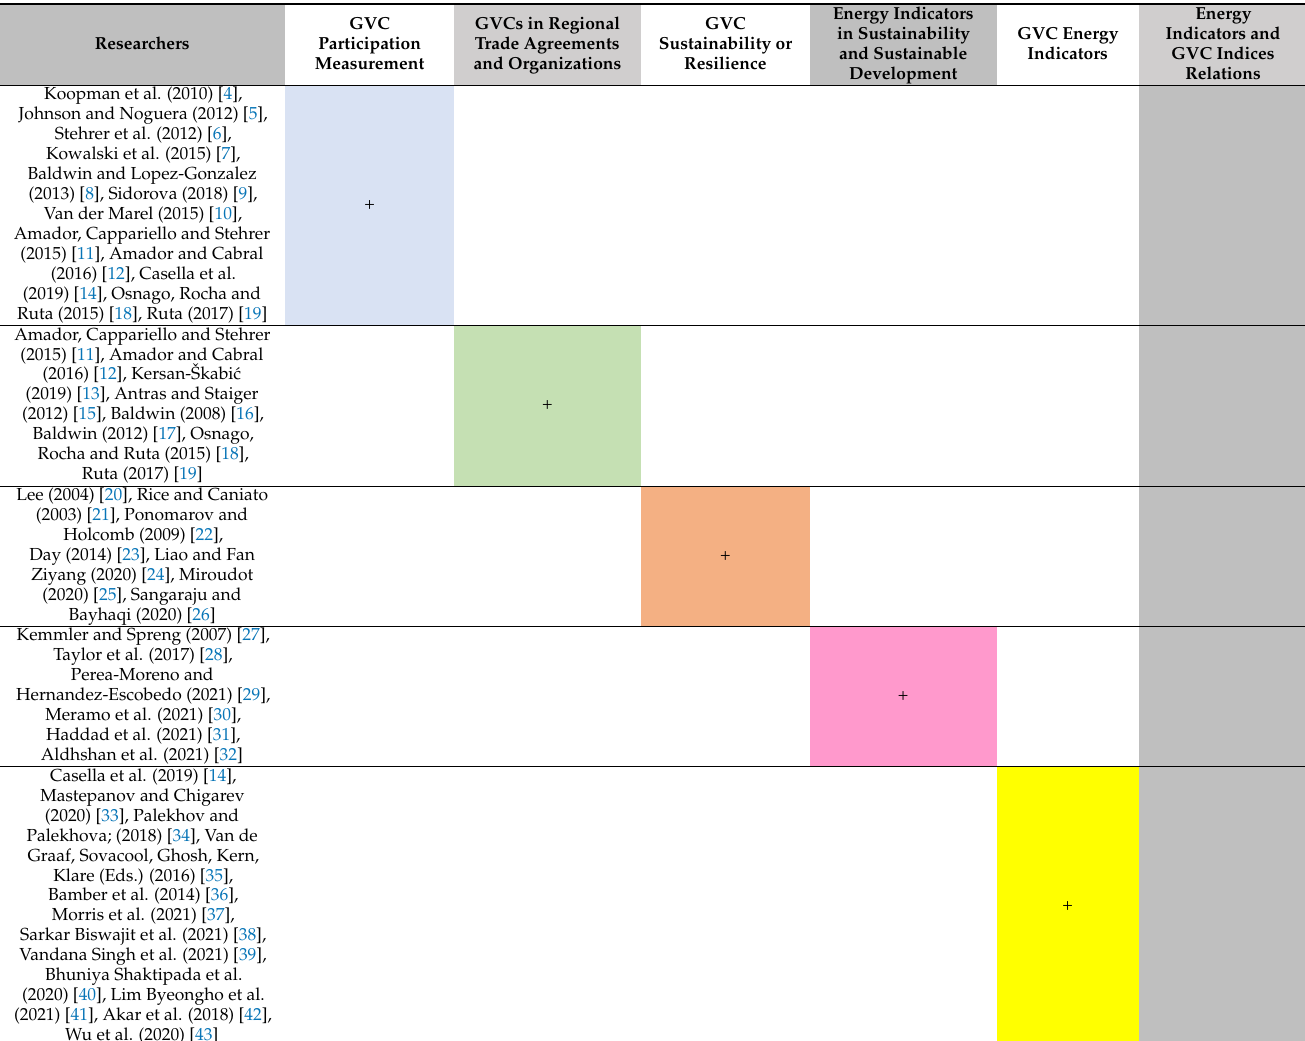
Table 2. Authors’ contribution to the study of GVC management and sustainability and the relation- ship between Countries’ Energy Indicators and the Indices of GVC